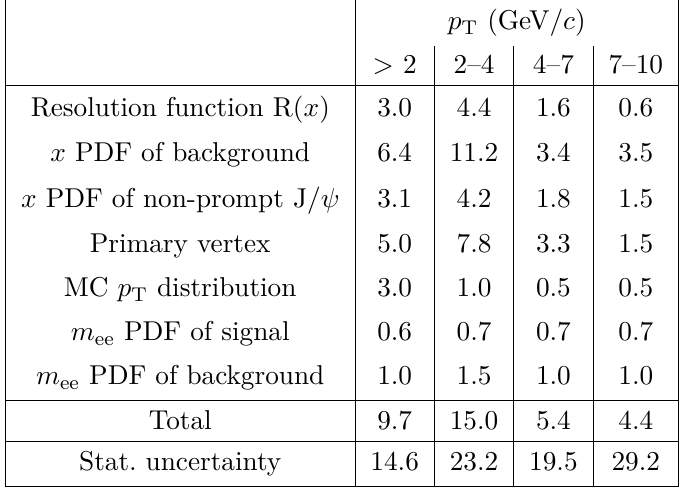
Table 2 . Systematic uncertainties of f B , expressed in %, for all p T intervals considered in the √ analysis performed at s = 5.02 TeV. In the last row the statistical uncertainties on f B are also